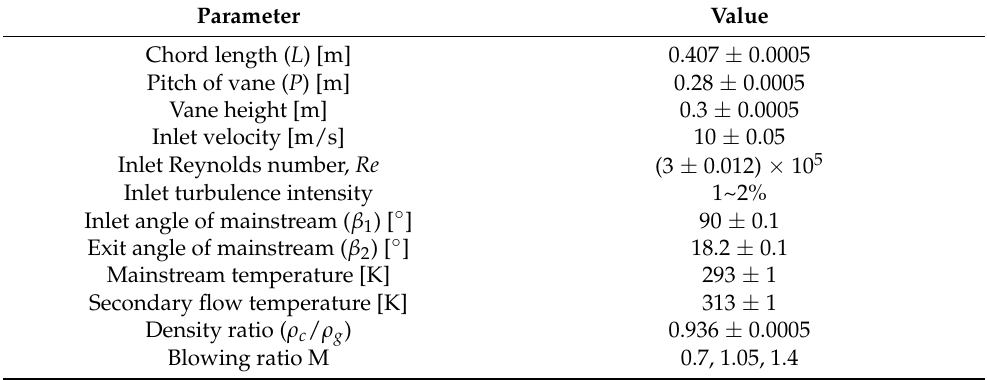
Table 1. Vane cascade parameters.